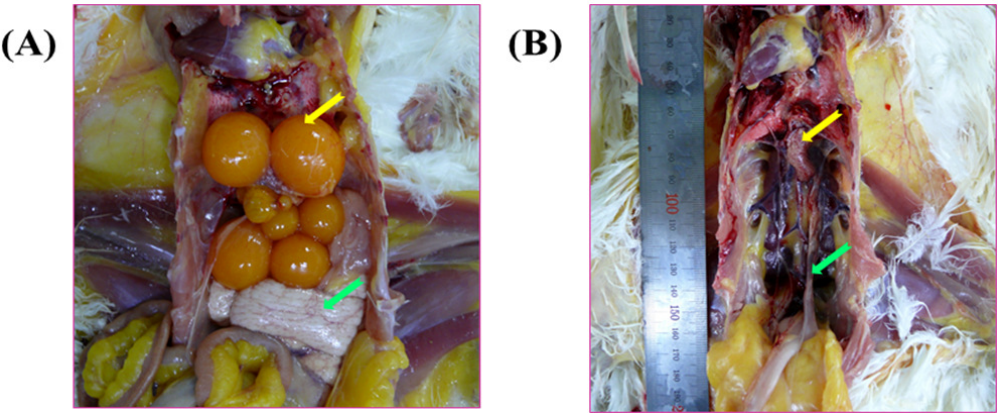
Figure 3. Changes in the ovarian follicles and oviduct of the vaccinated ( A ) and control ( B ) chickens at 5 weeks after challenge infection with IBV SNU8067. Compare the severe aplasia of the ovarian follicles (yellow-colored arrow) and atrophy of oviduct (green-colored arrow) with normal vaccinated chickens.